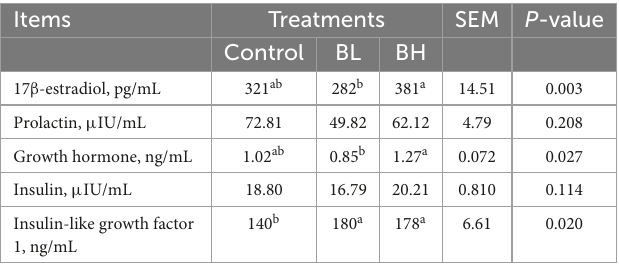
TABLE 6 Effects of biochanin A on endocrine indexes of plasma.